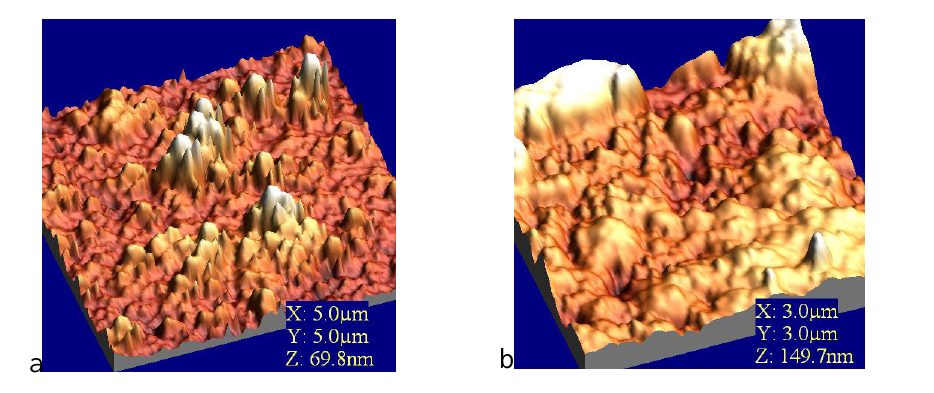
Figure 8. AFM images of linoleic acid/octadecyltrimethylammonium bromide/ 1 /laccase– a and linoleic acid/ octadecyltrimethylammonium bromide /1 /tyrosinase LB film– b . All images are 3 µm × 3 µm